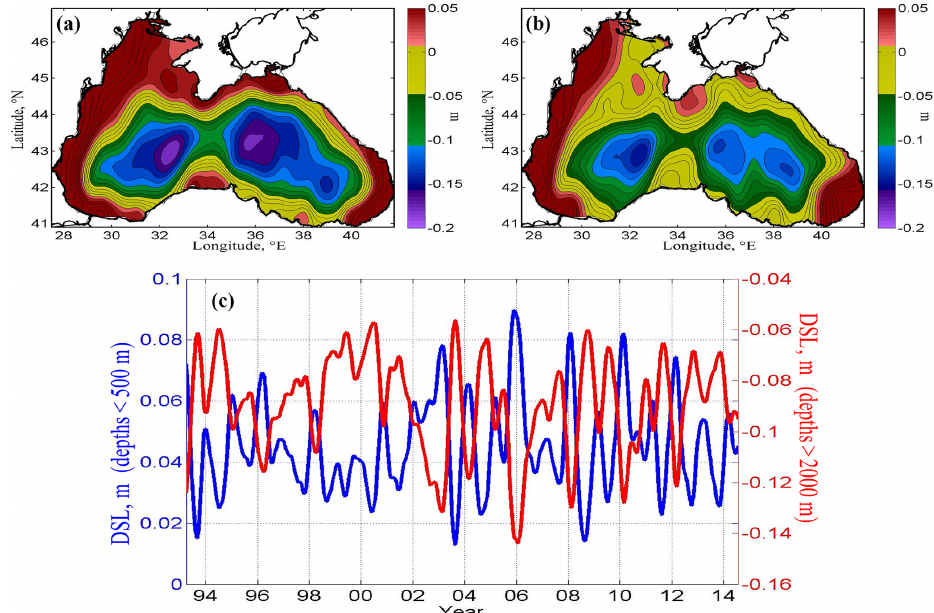
Figure 2. Average DSL distribution in (a) February, (b) July, and (c) DSL variability averaged over the central part (depths more than 2000m) and along the basin’s periphery (depths less than 500m). Time series are smoothed by a 90-day moving average.